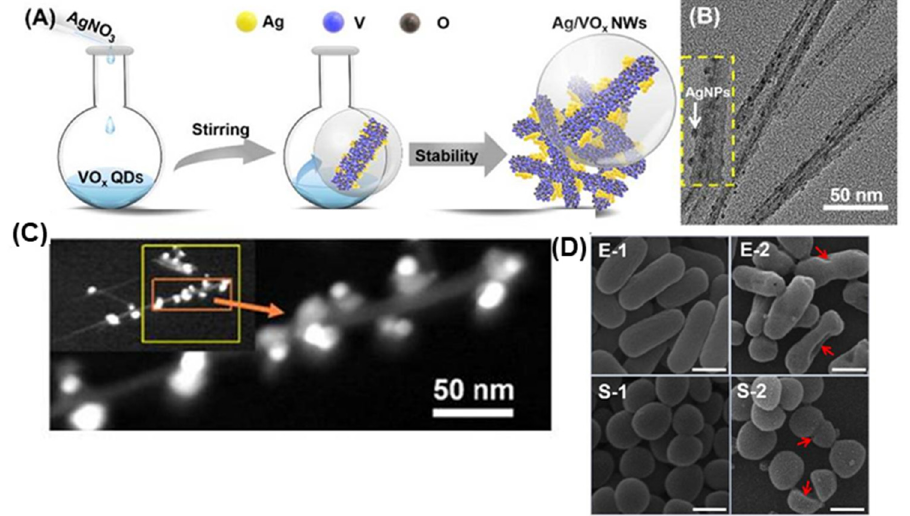
Figure 6. ( A ) Schematic illustration for synthesizing Ag/VOx NWs (nanowires), ( B ) TEM image of Ag/VOx nanowires, ( C ) HAADF ‐ STEM (high angle annular dark fi eld scanning transmission electron microscopy) of Ag/VOx NWs, ( D ) the morphology of E. coli and S. aureus characterized from SEM images without ( E ‐ 1 , S ‐ 1 ) and with Ag/VOx NWs (5 µg/mL) treatment ( E ‐ 2 , S ‐ 2 ), scale bars represent 500 nm. (Red arrows indicate bacterial cell damage). Adapted and reprinted with permission from [128].